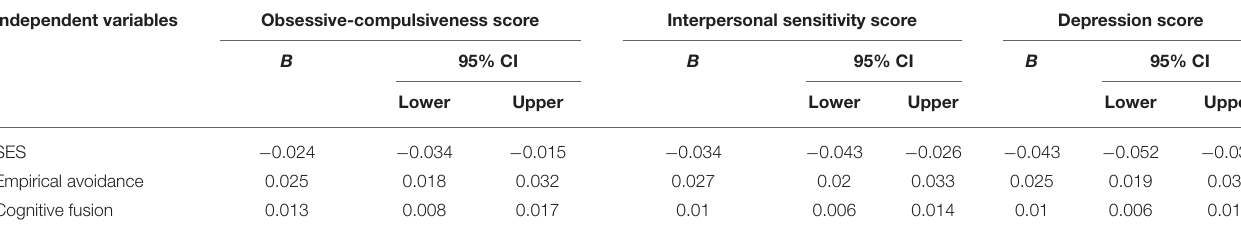
TABLE 4 | Linear regression of SES and psychological flexibility for the top three most common